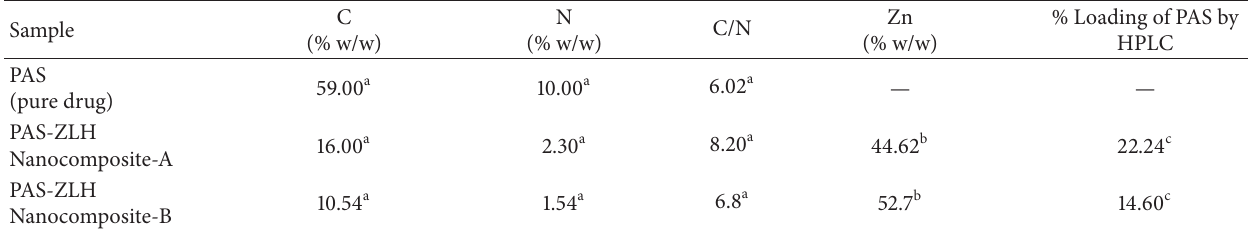
Table 2: Elemental analysis of organic and inorganic elements (nanocomposite-A).